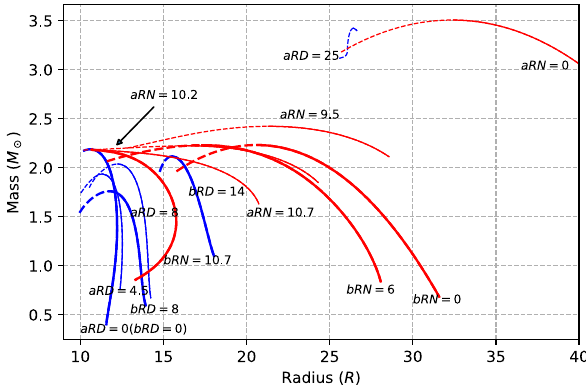
Fig. 5 Mass–radius relations of the hybrid stars of type (I) and (II) in Fig. 1, which are made of nuclear matter of SKb EoS and dark matter of EoS (1) with B = 0 . 035 or 0 . 055. The notations are the same with that in Fig. 3